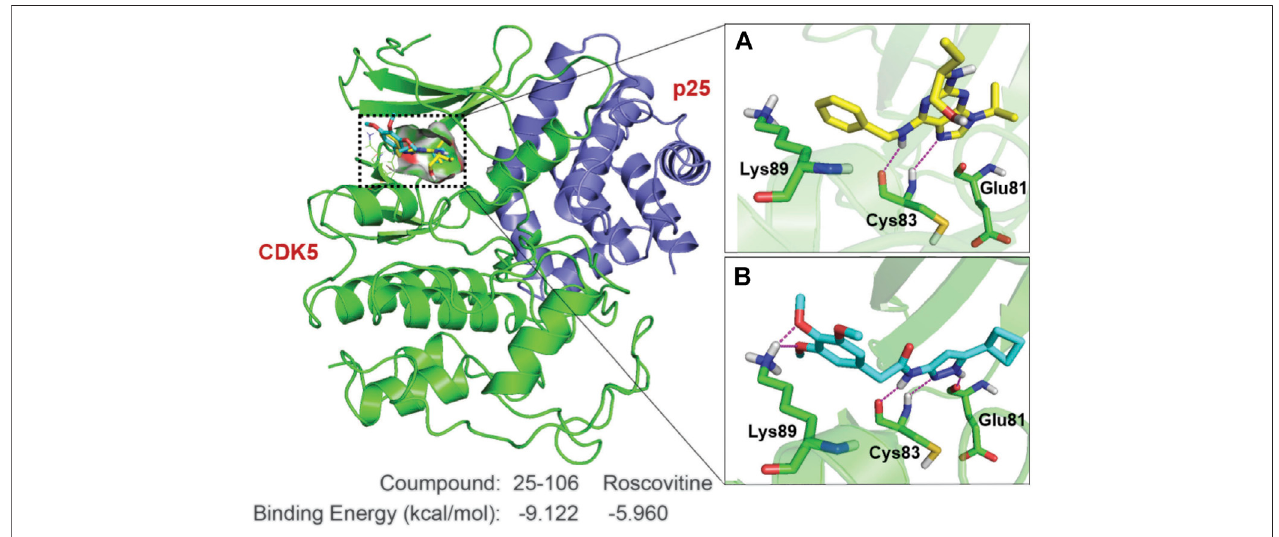
FIGURE4| Key interactionsmadeby25 – 106androscovitinewithCDK5/p25.CDK5(green cartoon)/p25 (bluecartoon)(PDB:1H4L).Hydrogenbondsareshown in magenta lines. (A) Roscovitine (represented by yellow sticks), (B) 25 – 106 (represented by cyan sticks).